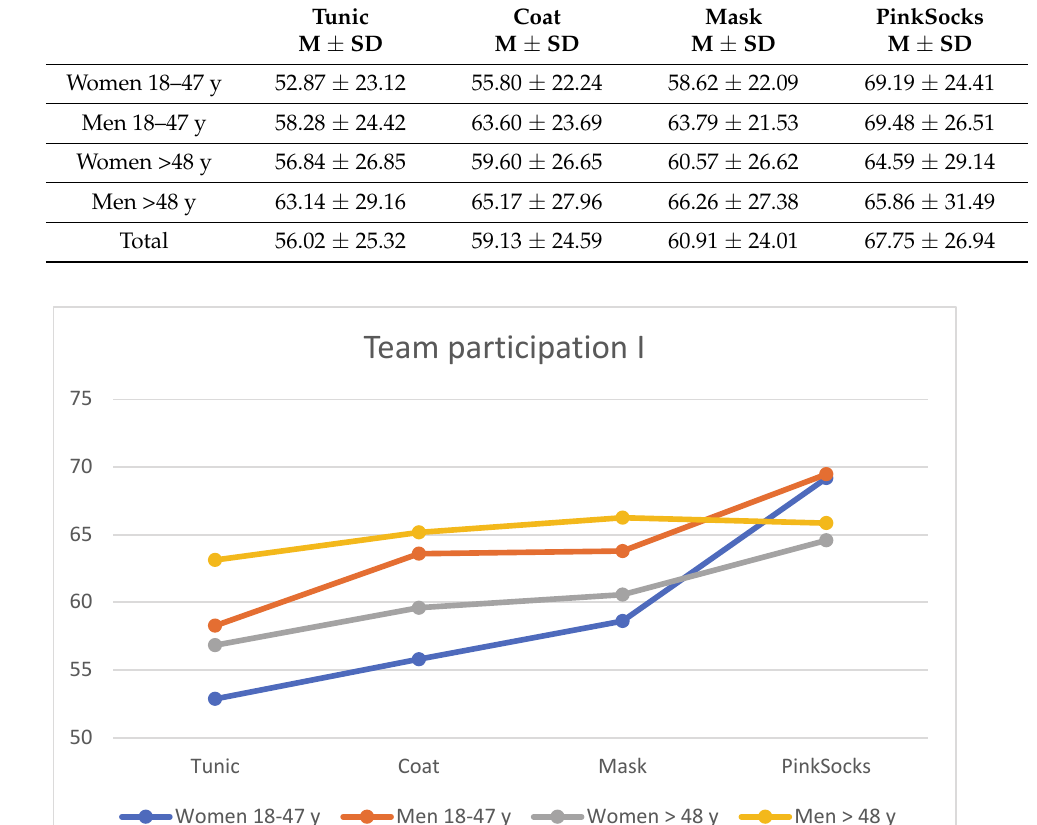
Table 5. Evaluation of the four photos according to team participation, age and gender (mean, standard deviation).